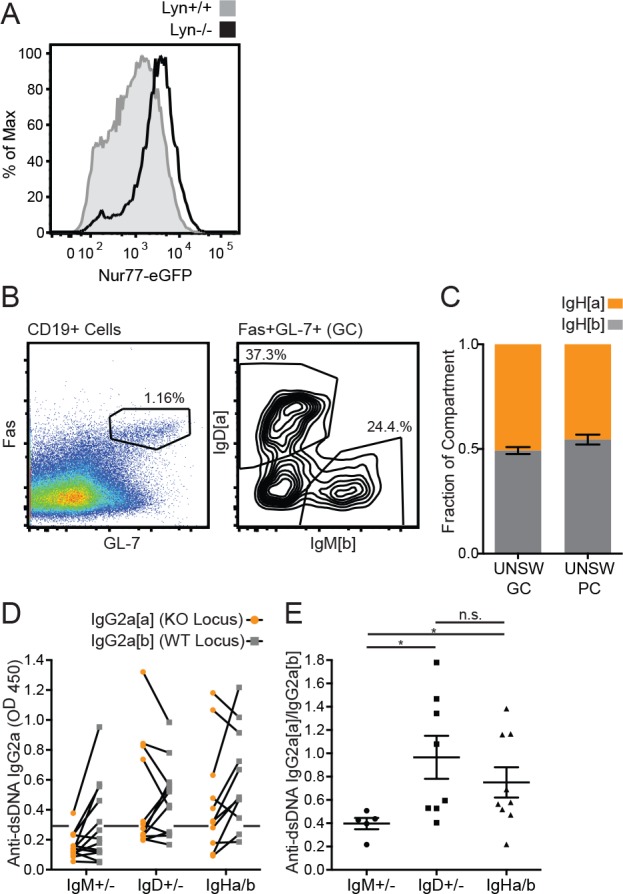
Nur77-eGFP in Lyn−/− B cells and the role of BCR allotype in Lyn−/− phenotypes.(A) Nur77-eGFP expression in splenic mature Fo B cells from Lyn+/+ and Lyn−/− reporter mice. (B) Gating scheme for determining the Ig locus of origin for germinal center B cells in 6-month-old IgM+/− Lyn−/− mice. (C) Relative contribution of IgHa+ and IgHb+ B cells to the splenic unswitched GC (CD19+ Fas+ GL-7+ IgM+) and unswitched PC (CD138+IgM+) compartments of 6-month-old IgHa/b Lyn−/− mice. (D) Anti-dsDNA IgG2a from each Ig locus in 5–6 month old IgM+/−, IgD+/−, and IgHa/b mice on the Lyn−/− background was quantified by ELISA. (E) The OD ratio of knockout (allotype a) to WT (allotype b) anti-dsDNA IgG2a was calculated for all mice in (D) in which either locus produced an OD >0.3. Histograms in (A) are representative of at least n = 3 mice of each genotype. Percentages in (B-C) were calculated using n = 5–6 mice of each genotype, and mean ±SEM is displayed. For (D), n = 10–13 mice of each genotype were analyzed. For (E), n = 5–9 autoantibody-positive mice were analyzed. Welch’s t test (E) was used to calculate p values, and mean ±SEM is displayed. *p<0.05.